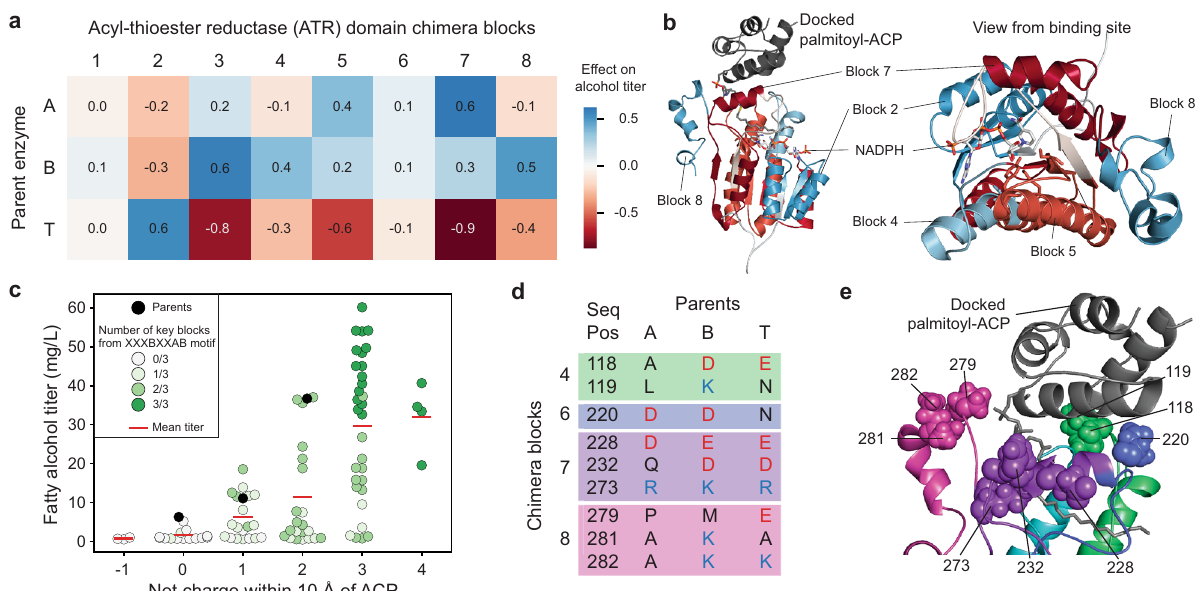
Fig. 4 Statistical analysis of the fatty alcohol production landscape. a Contributions of each sequence block to the alcohol production of chimeras. b Mapping of the contributions to the structural model of MA-ACR. Blocks with strong effects (either positive or negative) line up with key structural features such as the NADPH binding site, the active site and the ACP binding site. c Correlation between net charge near the binding site and fatty alcohol titer of chimeras. Chimeras with higher net charges tend to produce more alcohols. In addition, three key blocks were found to correlate with both activity and with charge. Combining all three of these blocks results in highly active enzymes. The statistics for the fi nalized dataset (mean, standard deviation and number of replicates) are available in Supplementary Table 5. d Positions in the parent sequence alignment that contain non-conserved charged residues within 10 Å of the putative ACP binding site (positively charged residues are shown as blue text, negatively charged residues are shown as red text). e Locations of key charged residues in the structural model of MA-ACR docked with palmitoyl-ACP. Optimal combinations of blocks could produce more favorable interactions with the ACP. Source data underlying Fig. 4c are provided as a Source Data fi